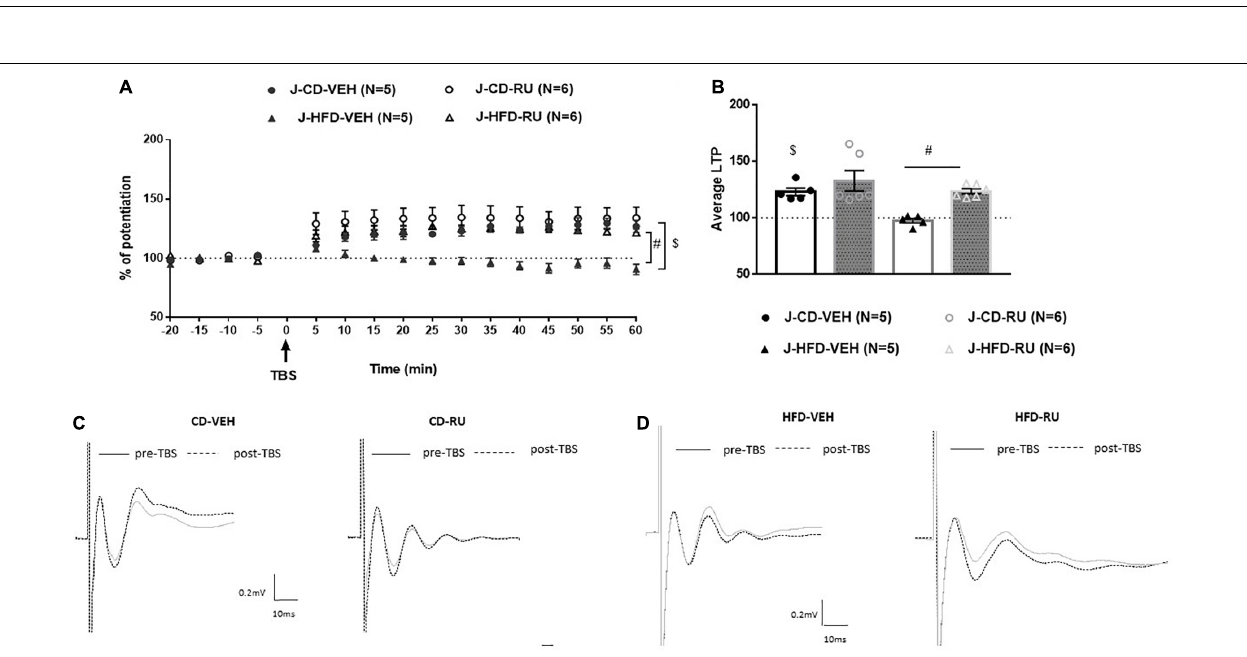
FIGURE 5 | Effects of systemic GR blockade on prefrontal LTP in HFD- and CD-fed juveniles. (A) Normalized fEPSPs recorded in vivo before and after TBS of the BLA-mPFC pathway. Each data point shows the average fEPSPs of the preceding 5 min. (B) Average LTP shown in panel (A) over the 60 min after TBS. (C,D) Representative average waveforms before and after TBS Horizontal bar = 10 ms; vertical bar = 0.2 mV. For juvenile animals systemically injected with RU-486 (RU) or vehicle (VEH) 30 min prior to TBS. RU treatment rescued HFD-impaired LTP in HFD-fed animals, and had no effect on control CD-fed animals. Two-way ANOVA with repeated measures on the 12 post-TBS time points showed significant effects of Diet ( $ p < 0.001) and Drug ( # p < 0.001), without a significant Diet × Drug interaction. Error bars show standard error of the mean (SEM).